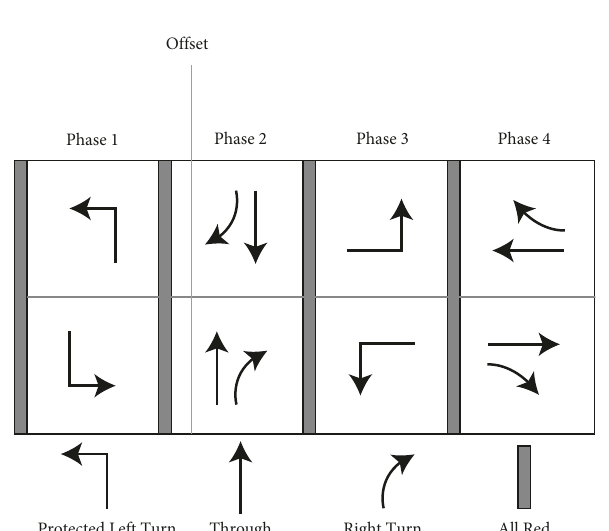
Figure 1: Sample of an intersection.